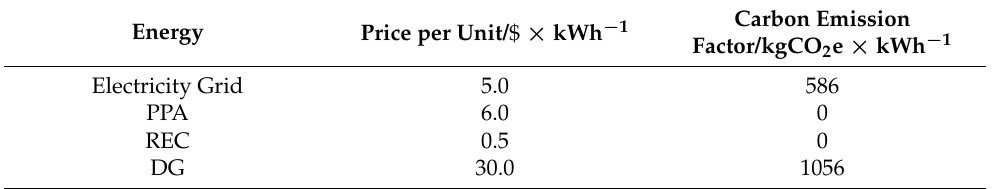
Table 2. Unit energy expenditure and carbon emission